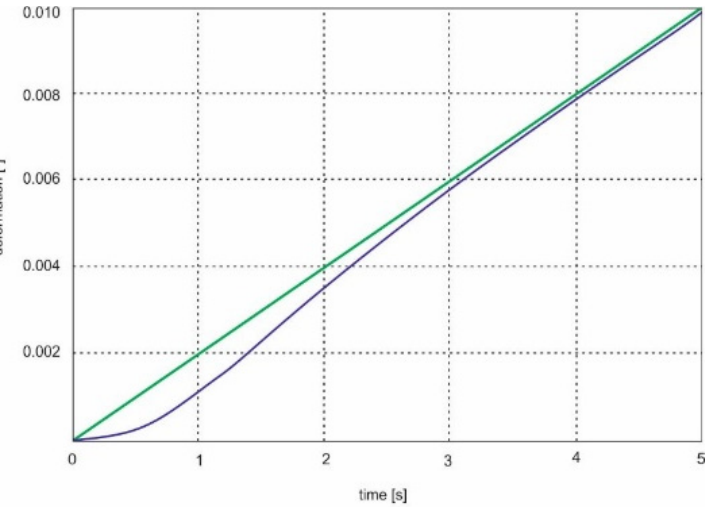
Figure 24. Comparison of the setpoint (green line) and the controlled variable (blue line) .